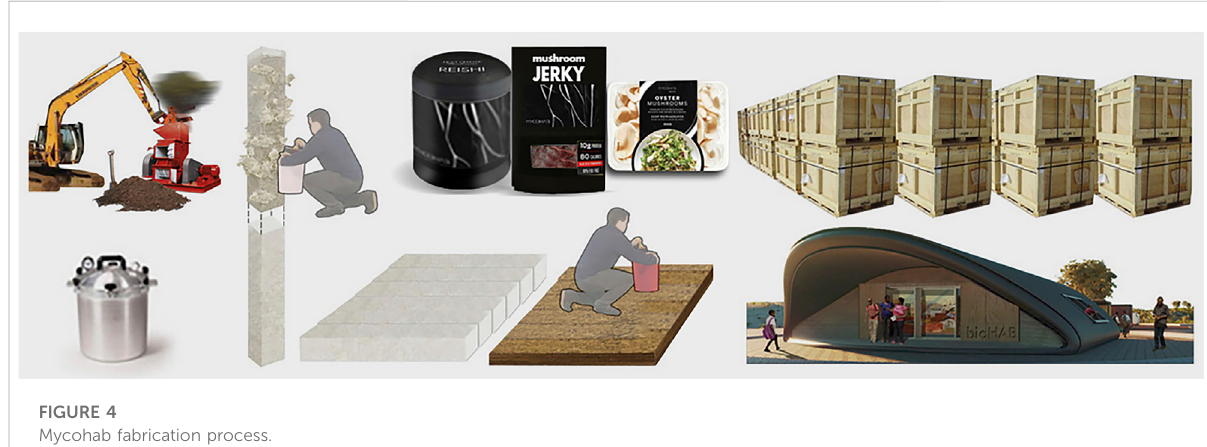
FIGURE 4 Mycohab fabrication